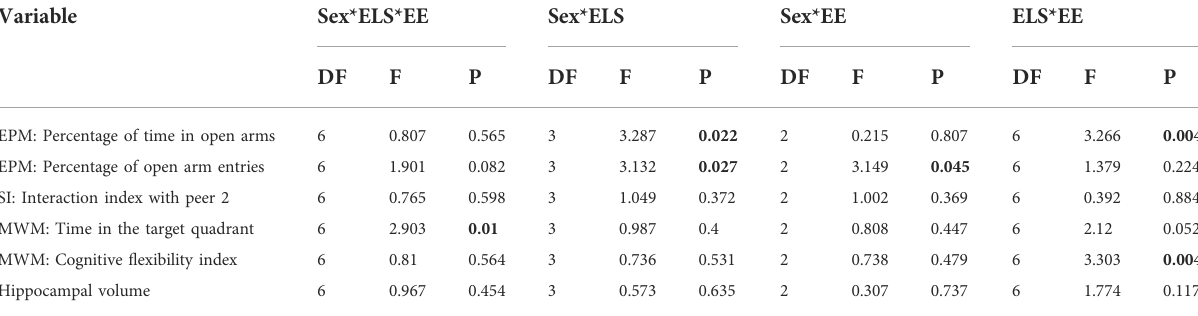
TABLE 1 Summary of 3-way ANOVA for each variable. Variable